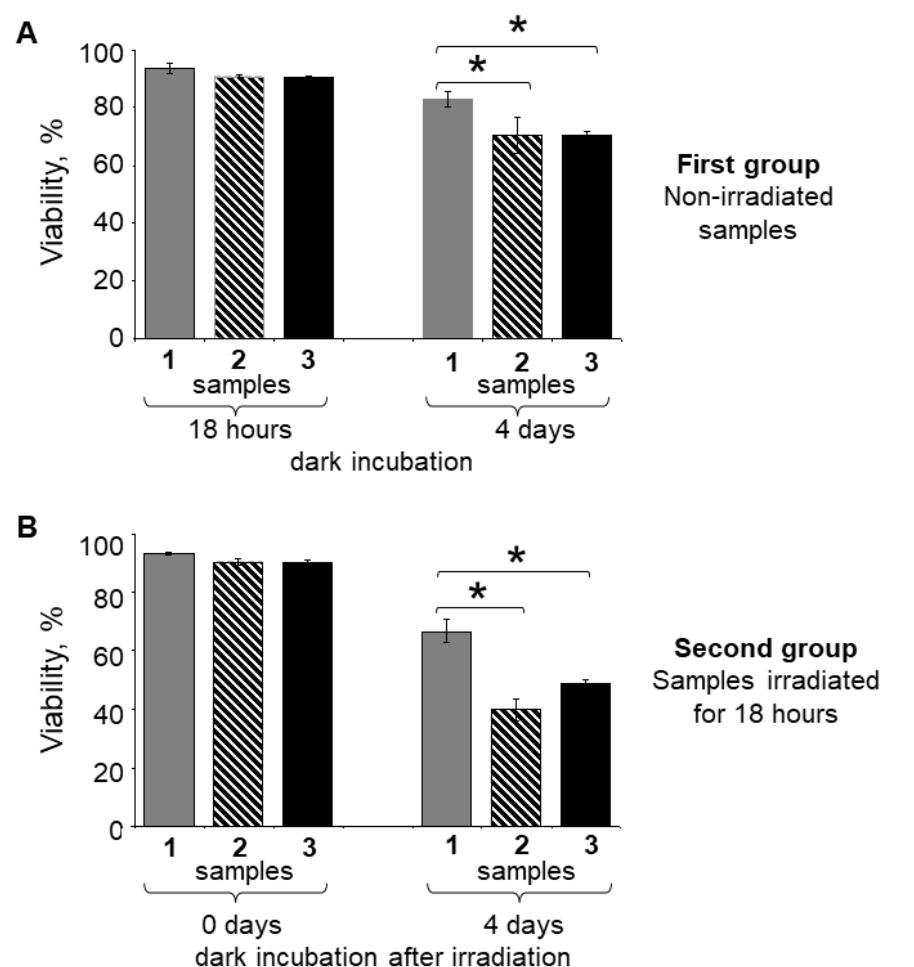
Figure 4. Comparative flow cytofluorimetry analysis of the cell viability. RPE cell samples were stained with fluorescent dye Live and Dead. The detection channels FITC (Ex 493 nm/Em 528 nm) and Cy3 (Ex 550 nm/Em 615 nm) were used. Samples: 1—original RPE cell culture without lipofuscin